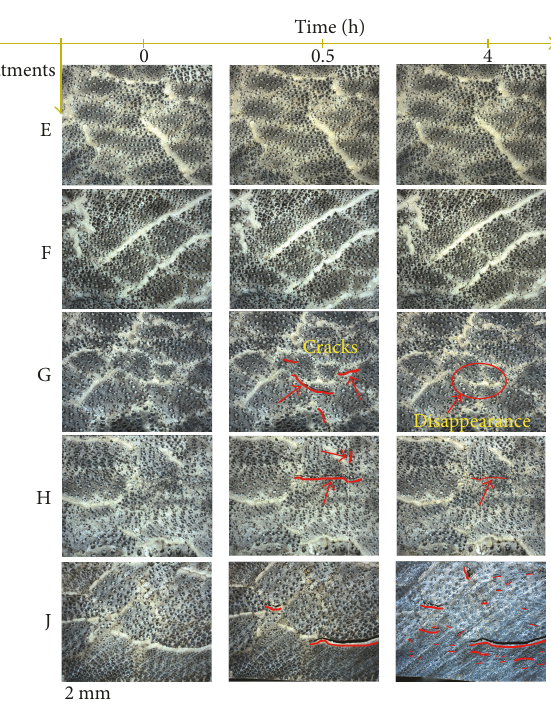
Figure 7: Representative optical images of the cross-section of bamboo scrimbers during the 4-hour treatments of E, F, G, H, and